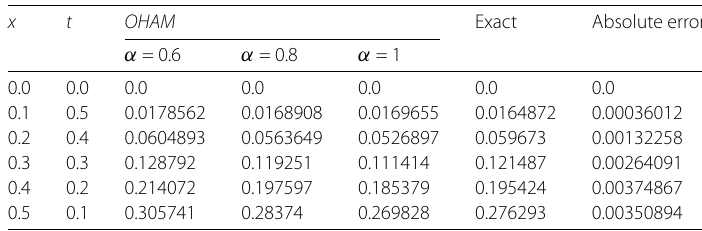
Table 3 Exact and approximate result of Test example 4.3 with various values of